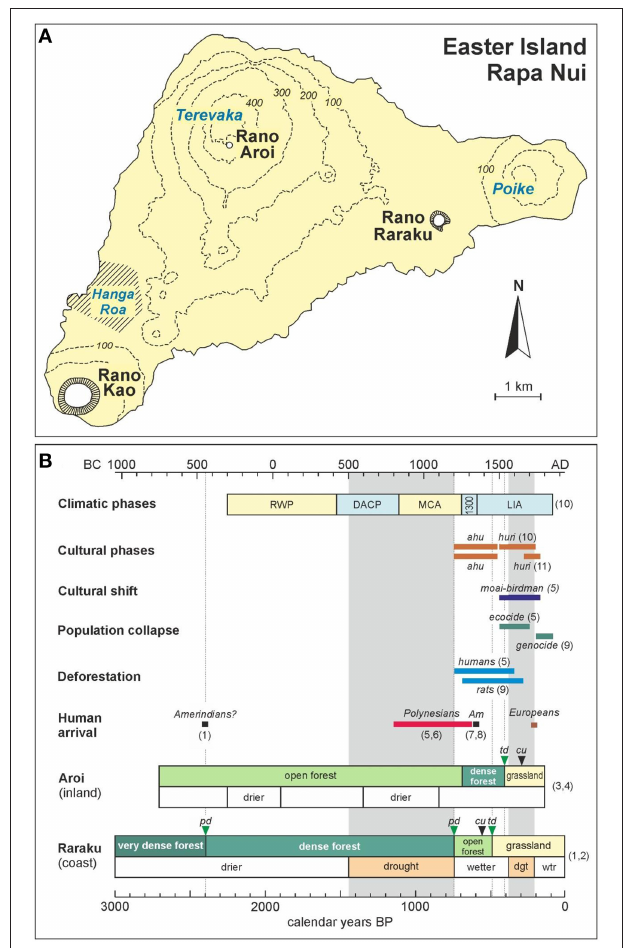
FIGURE 1 | (A) Sketch map of Easter Island indicating the localities mentioned in the text. (B) Summary of the climatic, ecological, and cultural trends of Easter Island over the last three millennia. The uppermost climatic phases summarize the current northern hemisphere and Pacific climatic phases according to Nunn (2007). Drought phases recorded at Raraku are shaded and deforestation pulses are highlighted by dotted lines. RWP, Roman Warm Period; DACP, Dark Ages Cold Period; MCA, Medieval Climate Anomaly; 1300, “1300 event;” LIA, Little Ice Age; Am, Americans; cu, first evidence of local cultivation; dgt, drought; pd, partial deforestation; td, total deforestation; wtr, wetter. References: 1, (Cañellas-Boltà et al., 2013); 2, (Horrocks et al., 2012a); 3, (Rull et al., 2015); 4, (Horrocks et al., 2015); 5, (Flenley and Bahn, 2003); 6, (Wilmshurst et al., 2011); 7, (Thorsby, 2012); 8, (Thromp and Dudgeon, 2015); 9, (Hunt, 2007); 10, (Nunn, 2007); 11, (McLaughlin, 2007).